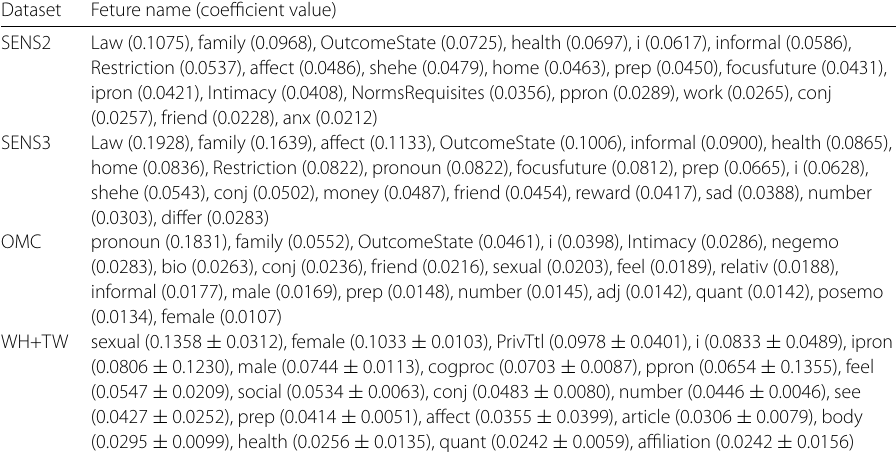
Table 13 Top-20 relevant features and their coefficients computed by the logistic regression classifier for the sensitive class